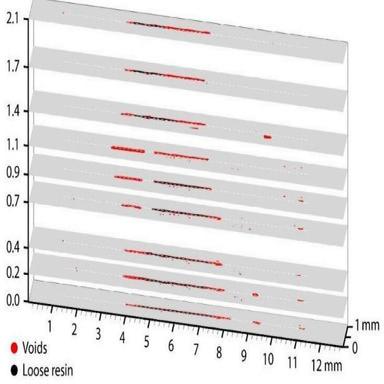
Void content in the sub-sections of each slice for the 10 � 10 mm defect specimen.